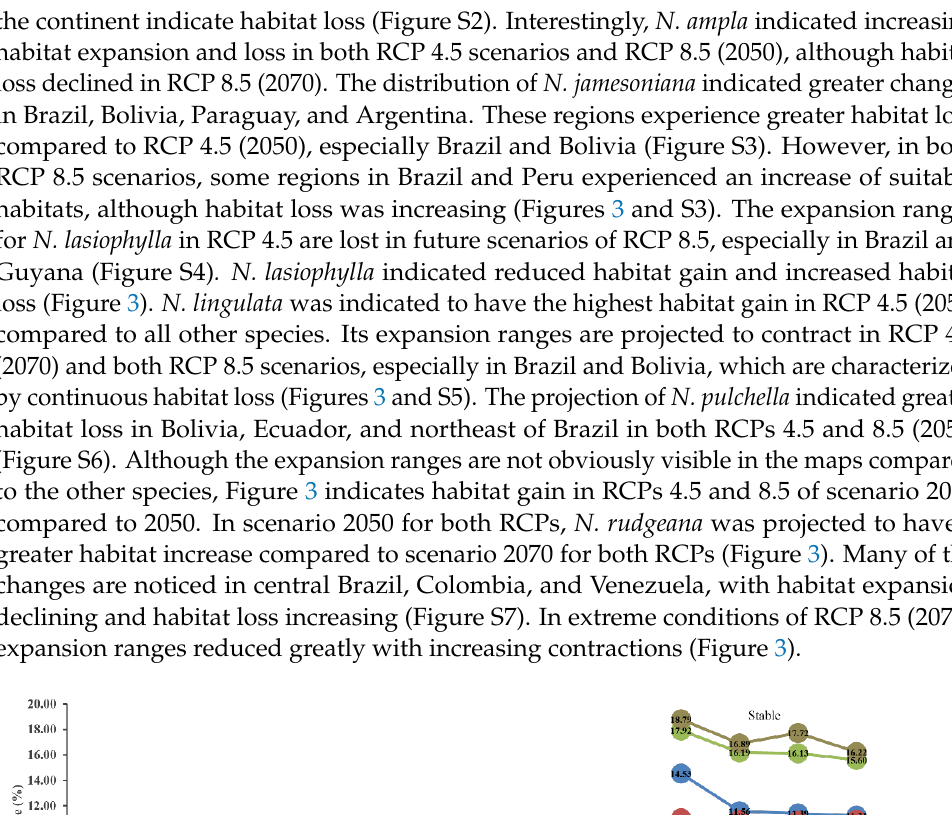
Figure 2. The current distribution of the seven Nymphaea species in South America: ( a ) N. amazonum ,